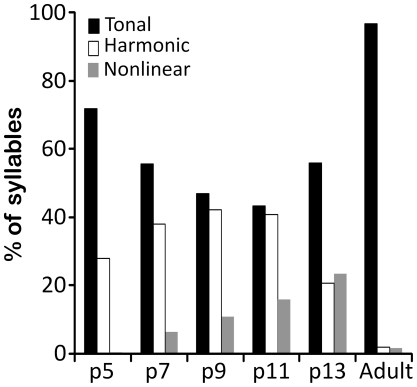
Harmonic and non-linear syllables are common in pups but not adults.With increasing pup age the proportion that had nonlinearities changed significantly (X2 (5, N = 2416) = 1417, p<0.001); increasing steadily developmentally. There were also significant changes in the proportions of harmonic syllables (X2 (5, N = 7672) = 1091, p<0.001). Adult mouse syllables were almost always tonal, the proportions of tonal syllables changed significantly over development (X2 (5, N = 17915) = 1737, p<0.001).